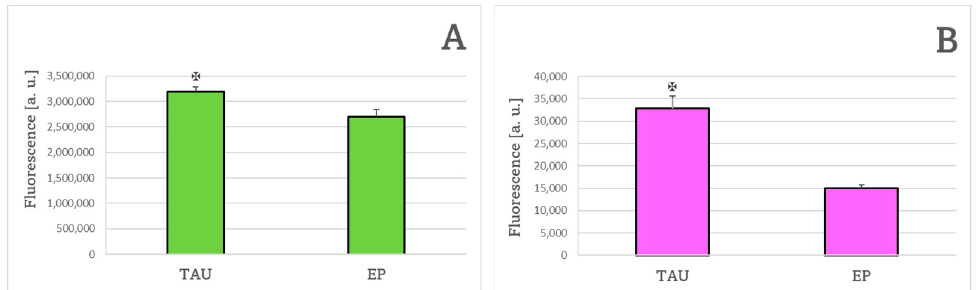
Figure 3. ROS level in TAU cells was significantly higher compared to EP controls as estimated with 2 (cid:48) ,7 (cid:48) -dichlorodihydrofluorescein diacetate ( A ) and dihydroethidium ( B ) after 24-h treatment. (cid:122) p < 0.05 (TAU vs. EP); n = 3.